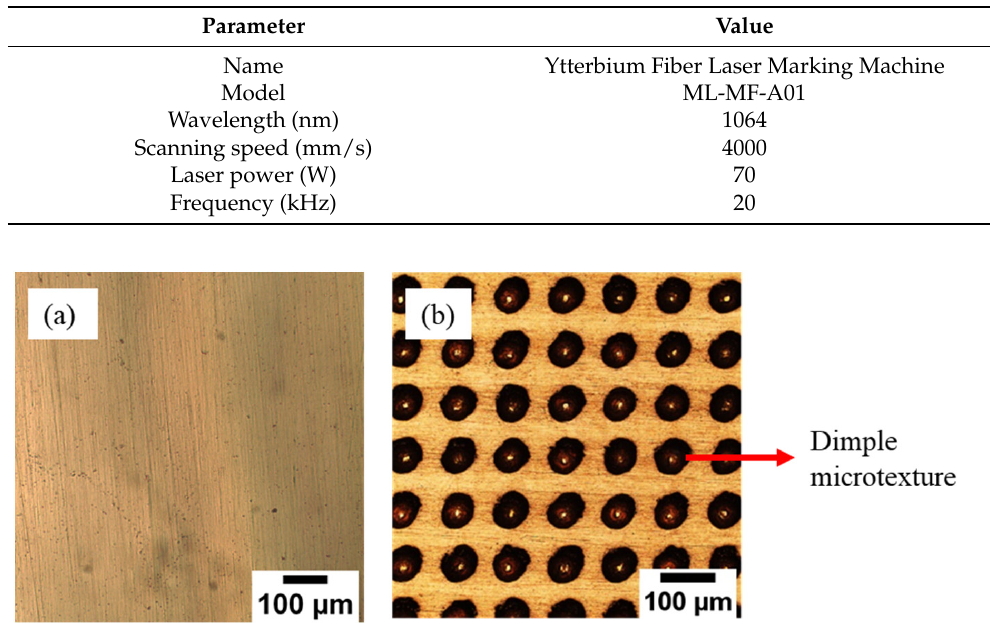
Figure 1. The surface of the copper substrate, ( a ) before surface texturing and ( b ) after surface texturing.